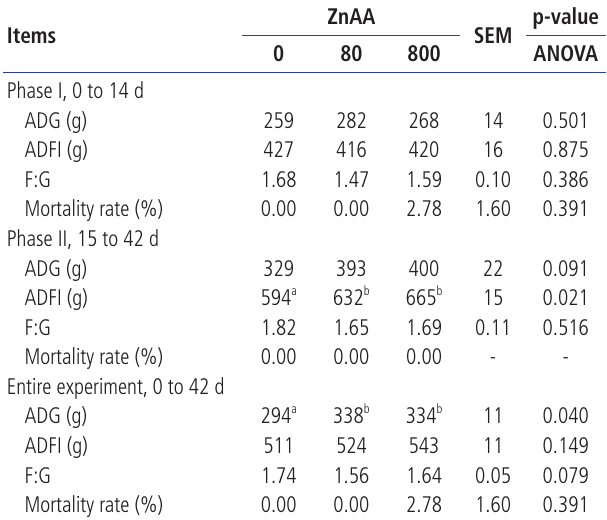
Table 6. Effects of zinc amino acid complex (ZnAA) on hematological parameters in weaned pigs 1) (Zn, mg/kg) ZnAA p-value SEM 0 80 800 ANOVA